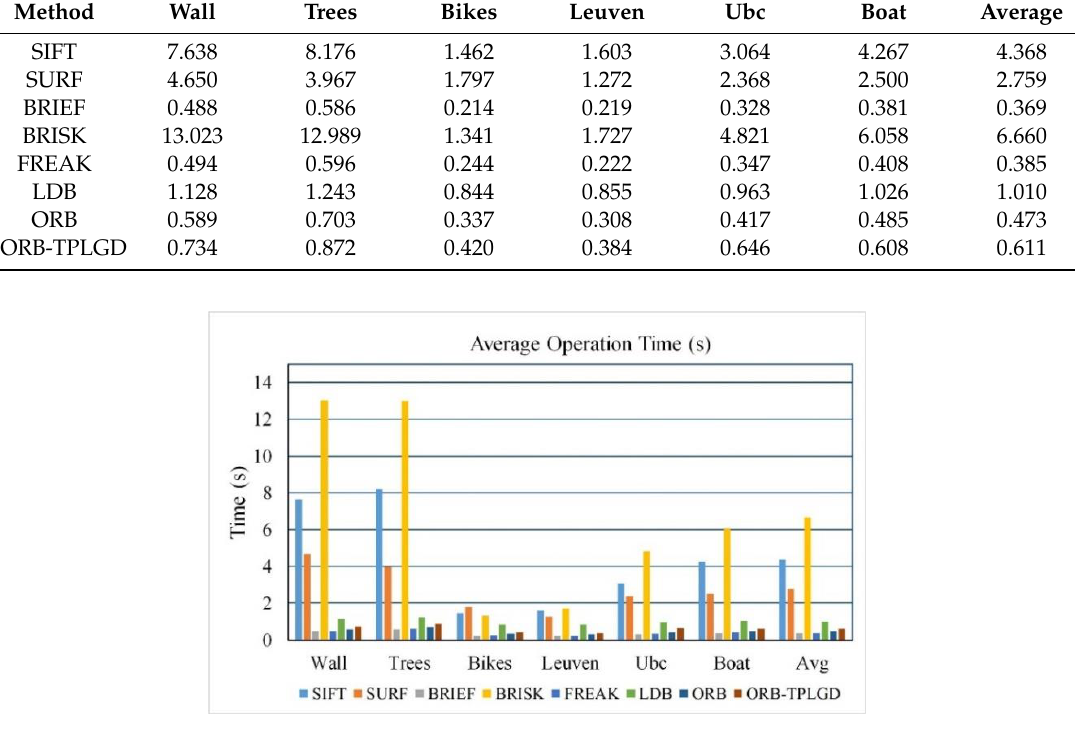
Figure 11. Average matching time based on Oxford dataset.